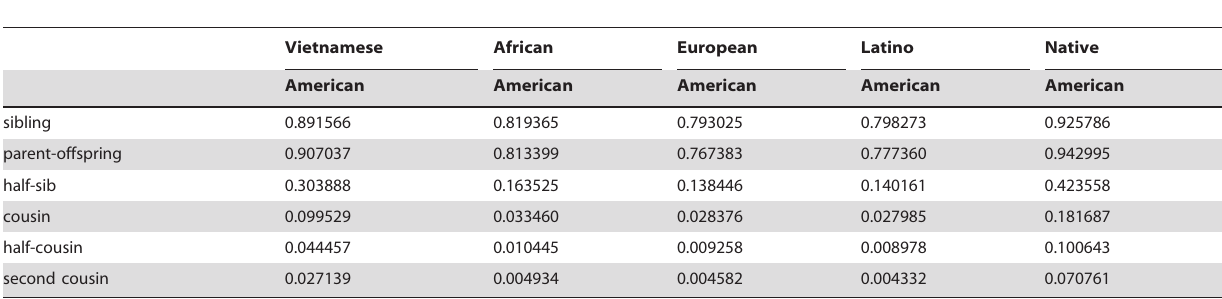
Table 4. Sibling test identification rates for different Y-sharing relatives and population